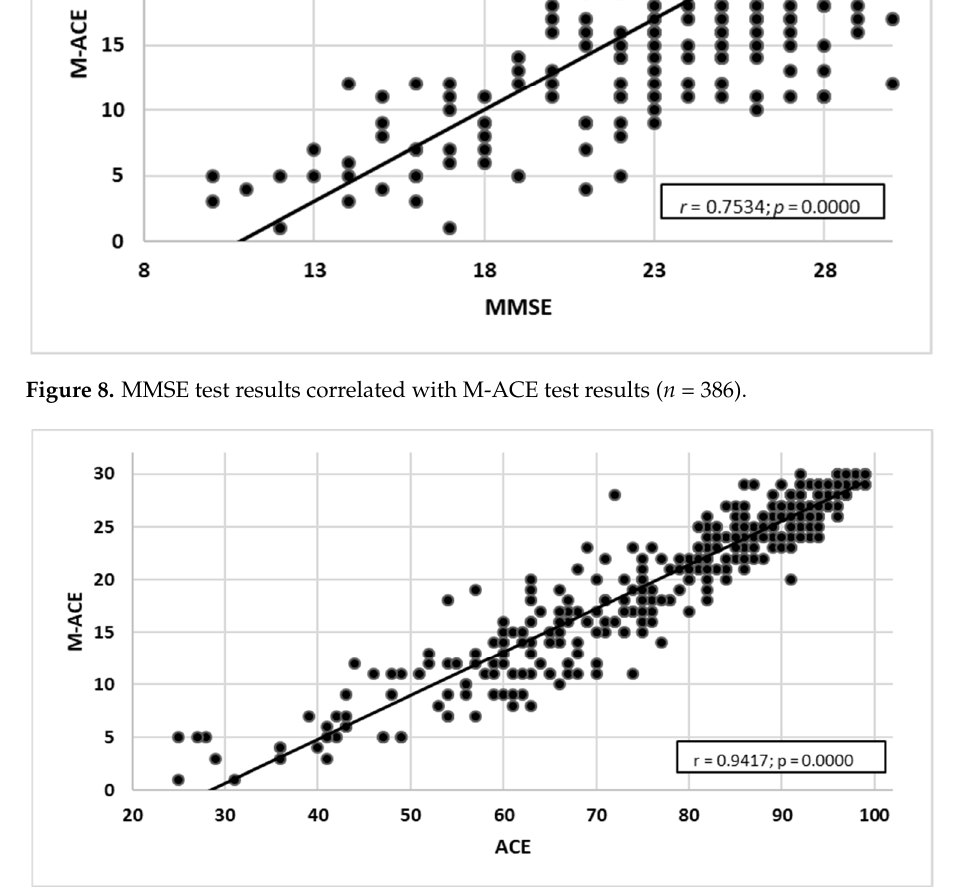
Figure 9. ACE-III test results correlated with M-ACE test results.